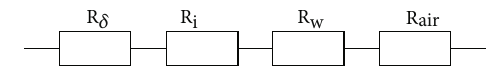
Figure 5: Thermal resistance analysis of series model.